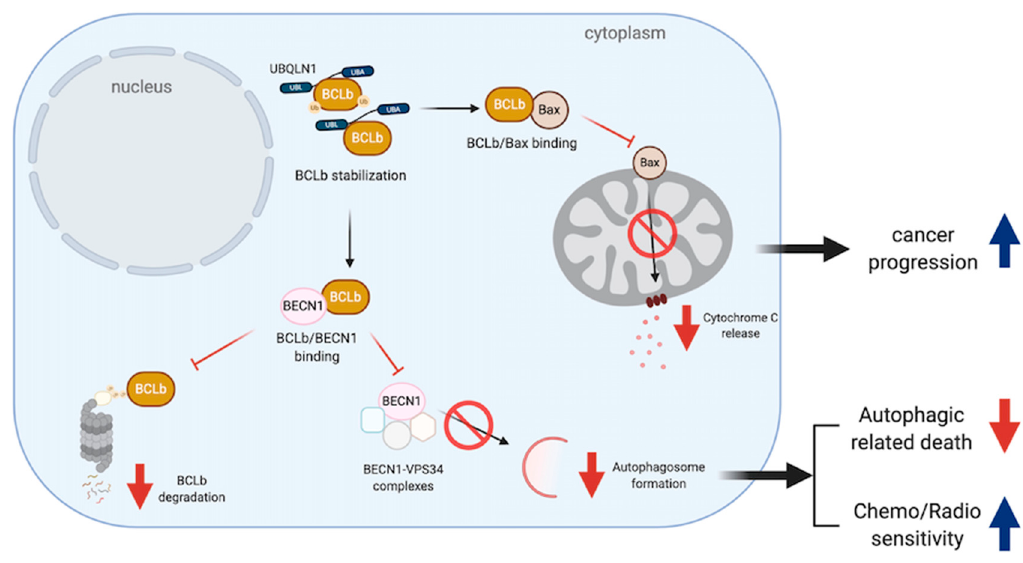
Figure 3. UBQLNs and BCLb/BCL2L10 networking in cancers. BCLb stabilization increases the chance of BCLb-Bax binding leading to apoptosis reduction and cancer progression. Moreover, such a stabilization can increase the chance of BCLb to bind to BECN1. BCLb-BECN1 association causes a reduction of BCLb degradation and reduces autophagosome formation by disrupting BECN1-VPS34 complexes. The reduction of autophagy a ff ects both cell death mechanism and chemo / radio